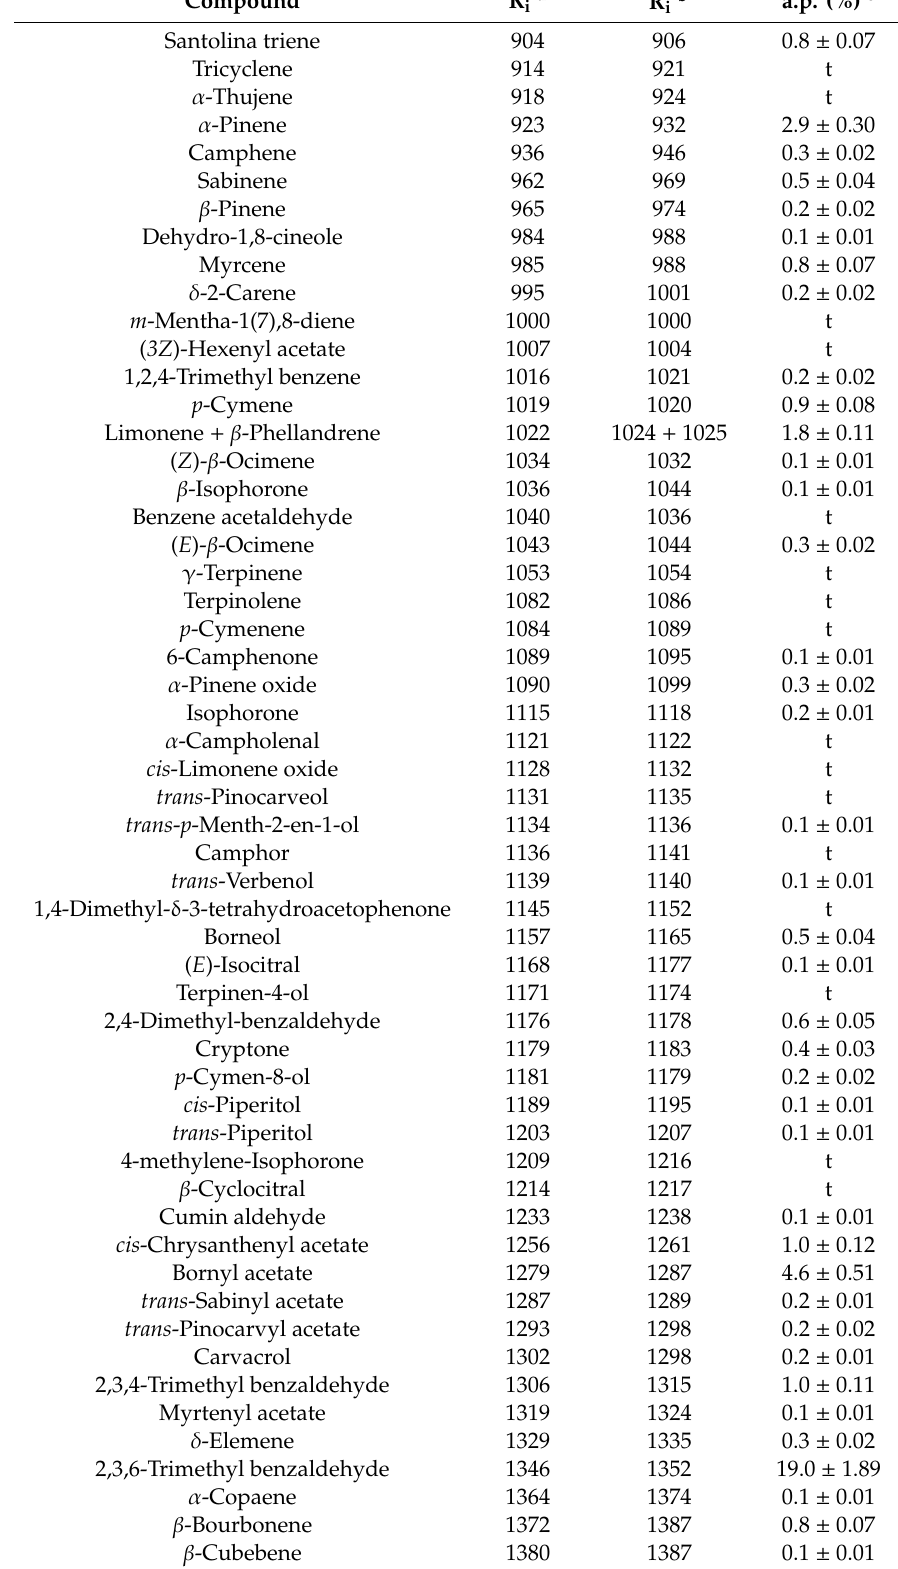
Table 1. Chemical composition of the essential oil of the aerial parts (leaves and stems) of F. nodosa subsp. geniculata from